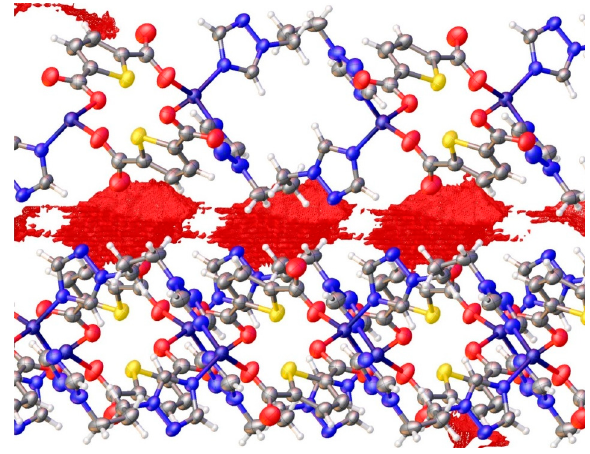
Figure 5. Representation of the voids in the structure of the complex [Zn(tdc)(btrp)] ∙ nDMF ( 2 ).